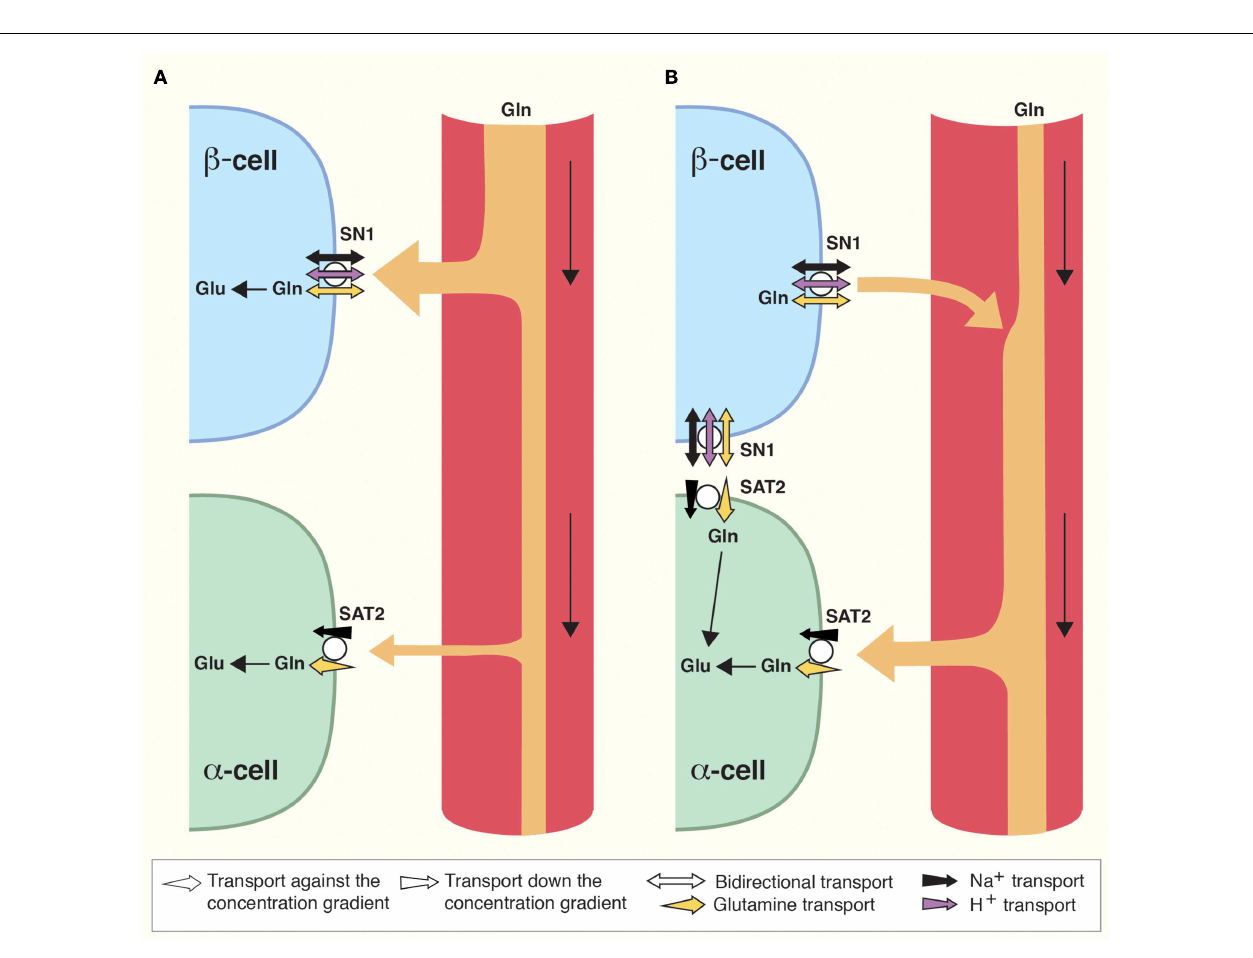
islets has lower concentrations of Gln and glucose. Gln now preferentially activates SAT2 on α -cells due to its higher affinity for Gln. In addition, changes in the Gln gradient across the cell membrane of β -cells may stimulate SN1 to release glutamine which can then be taken up by adjacent α -cells. Enhanced Gln metabolism in α -cells stimulates secretion of glucagon which raises blood glucose